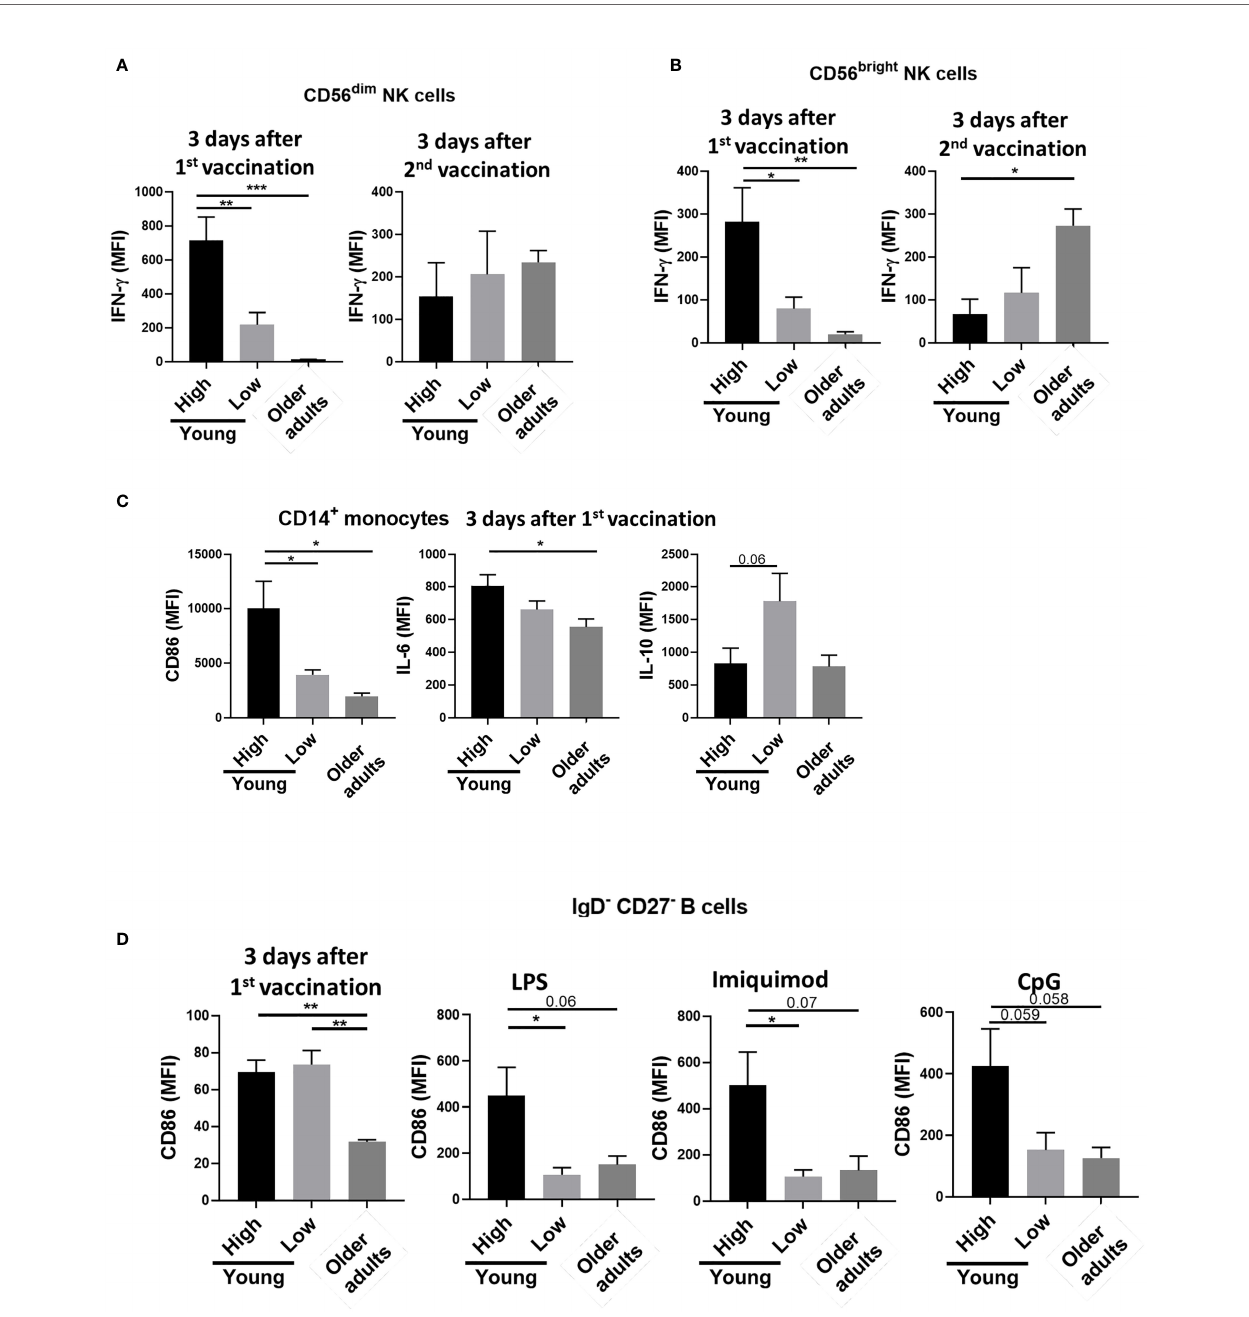
FIGURE 5 | Stronger NK and monocyte activation after the fi rst vaccination and TLR-induced IgD-CD27-double-negative (DN) B cell activation in subjects with higher early antibody levels IFN- g expressions in CD3 - CD56 dim (A) or CD3 - CD56 bright (B) NK cells; CD86, IL-6, and IL-10 expression in monocytes (C) 3 days after the fi rst vaccination were compared between high and low sVNT groups of the young vaccinees and the older adult vaccinees. (D) CD86 expression 3 days after the fi rst vaccination and CD86 levels after LPS, imiquimod, and CpG stimulation were compared between high and low sVNT groups. Statistical signi fi cance was determined using ANOVA with Tukey ’ s multiple-comparisons testing between all groups. (* p value < 0.05; ** p value < 0.01; *** p value <